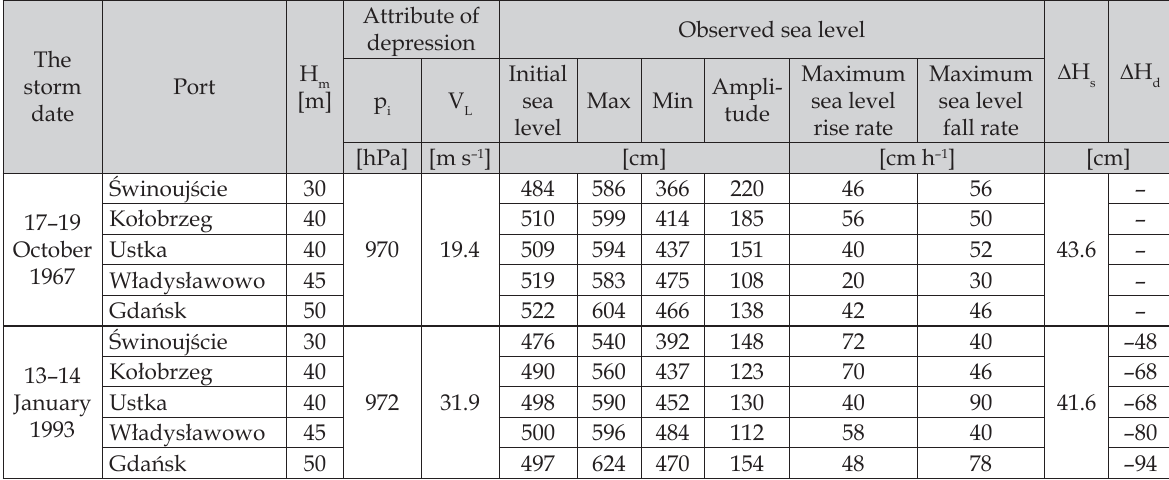
Table 2. Parameters of the storm surges and falls